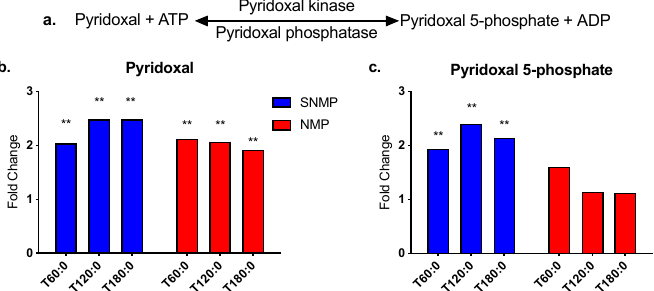
Figure 5. Vitamin B6 metabolism during SNMP vs. NMP. (a) Pyridoxal 5-phosphate (PLP) is generated from pyridoxal in a reversible reaction requiring ATP. SNMP livers demonstrate a significant increase in both (b) pyridoxal and (c) PLP levels during perfusion, whereas NMP livers only demonstrate a significant increase in pyridoxal. ** indicates p ≤ 0.05 and * indicates 0.05 < p < 0.10. Abbreviations: ATP, adenosine triphosphate; ADP, adenosine diphosphate; PLP, pyridoxal 5-phosphate; SNMP, subnormothermic machine perfusion; NMP, normothermic machine perfusion; x-axis represents fold change at 60, 120, and 180 min compared to pre-perfusion concentrations.